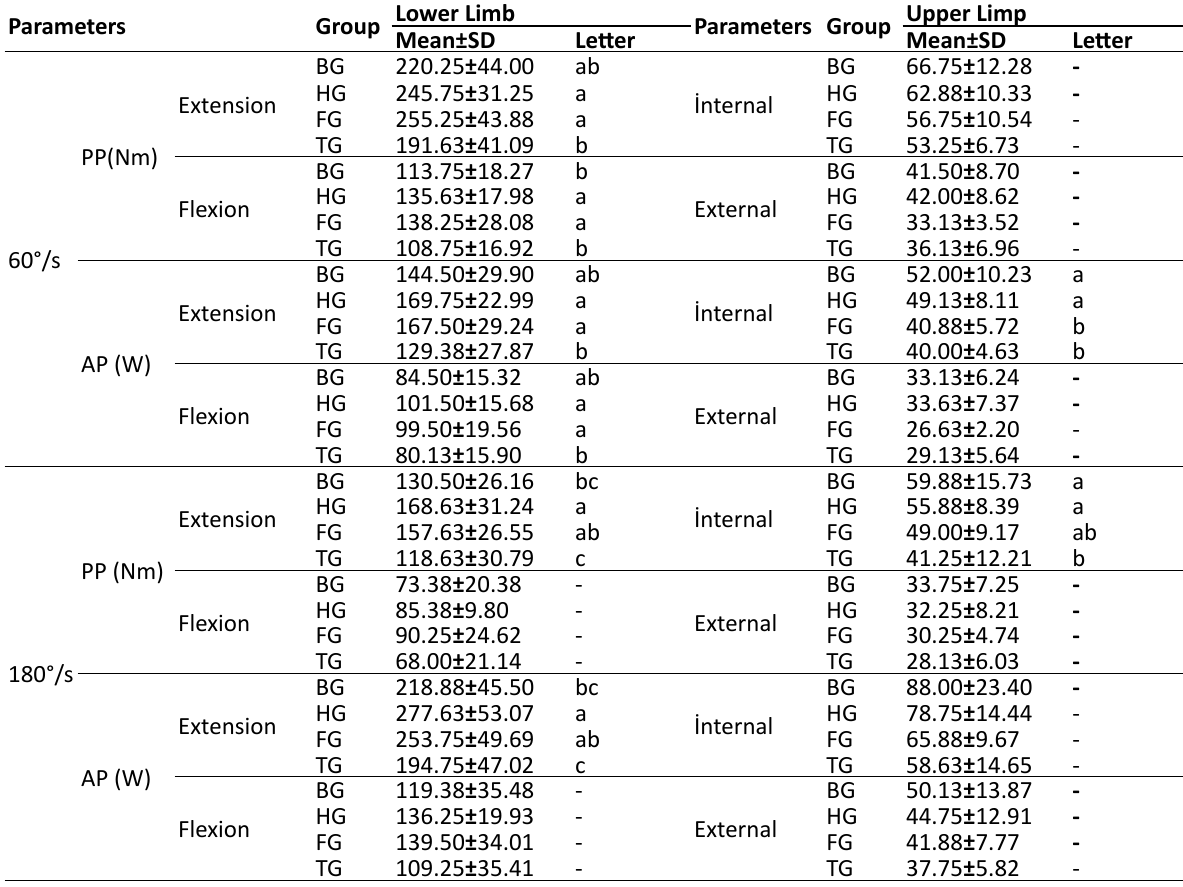
Table 3. Dominant arm and leg isokinetic test results of the participants at 60°/s and 180°/s rotation